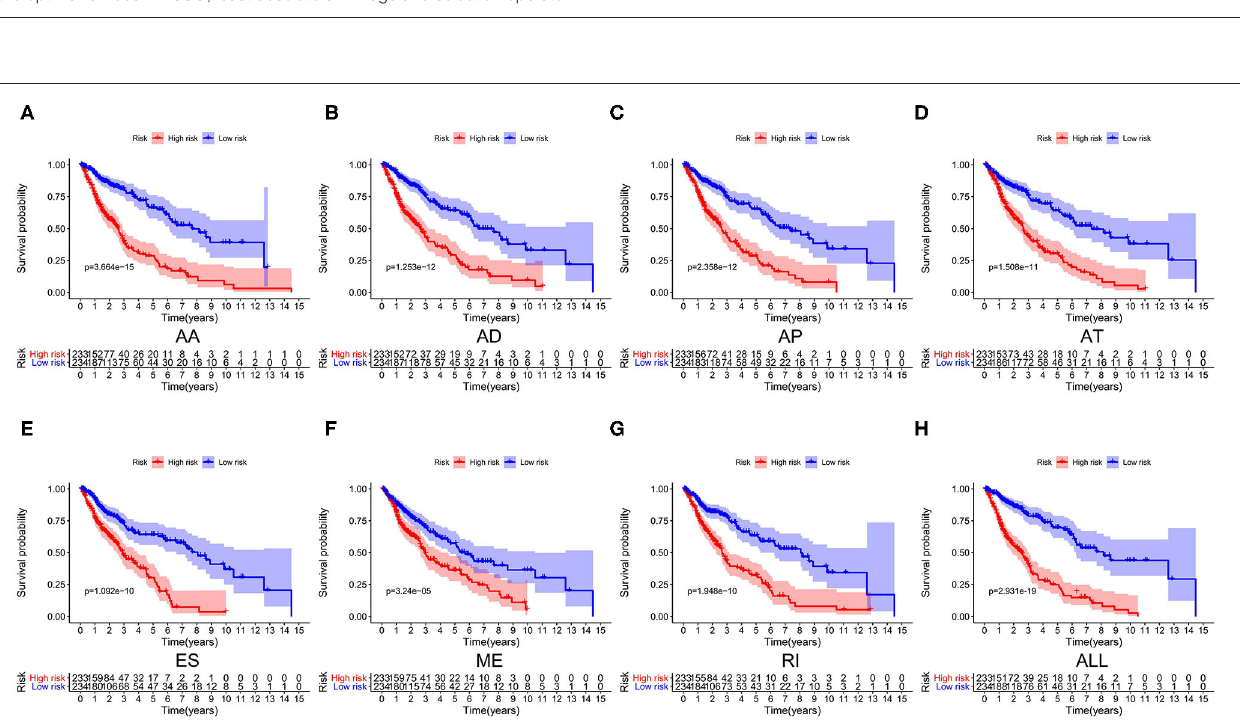
FIGURE 4 | LASSO regression analysis of survival-related AS events (all). (A) Cross-validation for the selection of optimal parameter (lambda) and dotted vertical lines were drawn at the optimal values. (B) LASSO coefficient profiles of the candidate survival-related AS events. AS events with non-zero coefficients were identified by the optimal lambda. LASSO, least absolute shrinkage and selection operator.